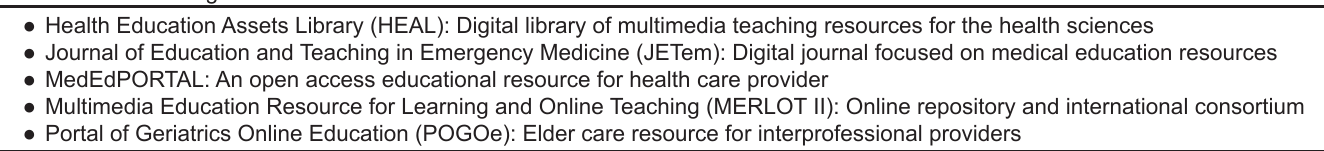
Table 2. Outlets for digital